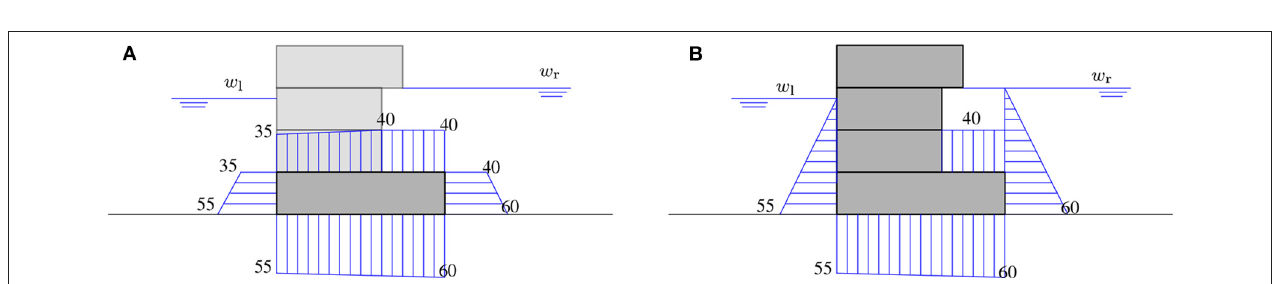
FIGURE 4 | Resulting water pressure (A) on the entire wall, when considering global equilibium, and (B) on block 1 when considering internal